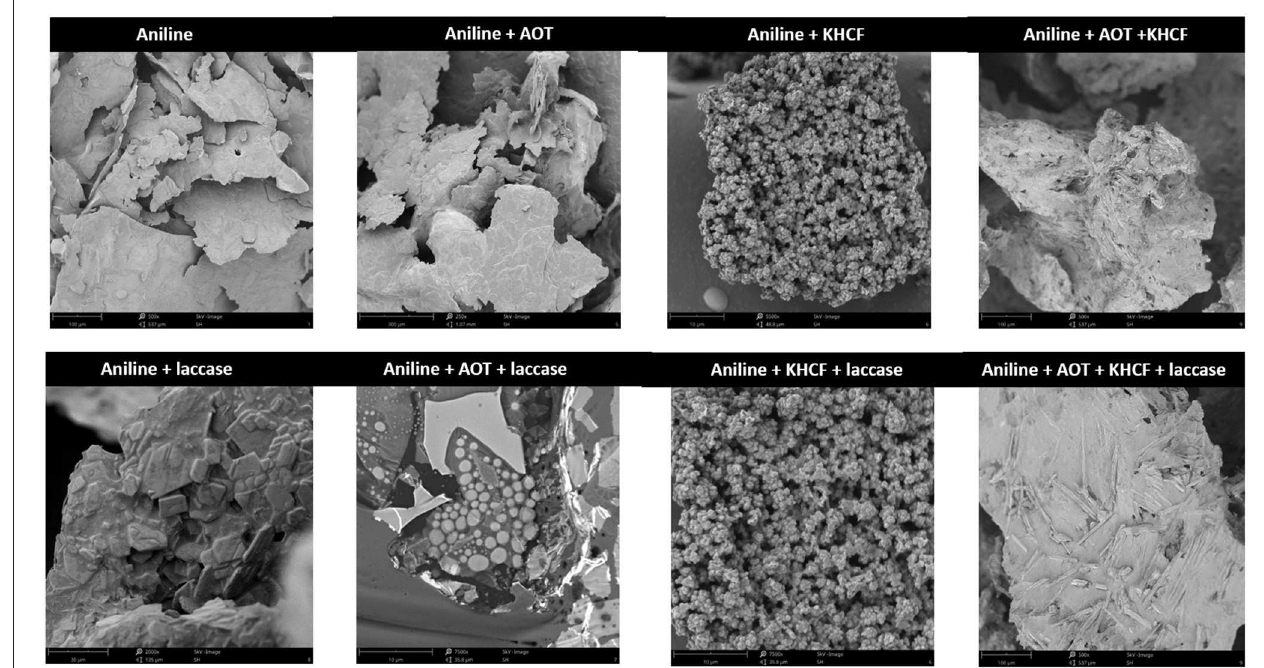
FIGURE 2 | Scanning electron microscopy of products of aniline oxidation by laccase using additives.